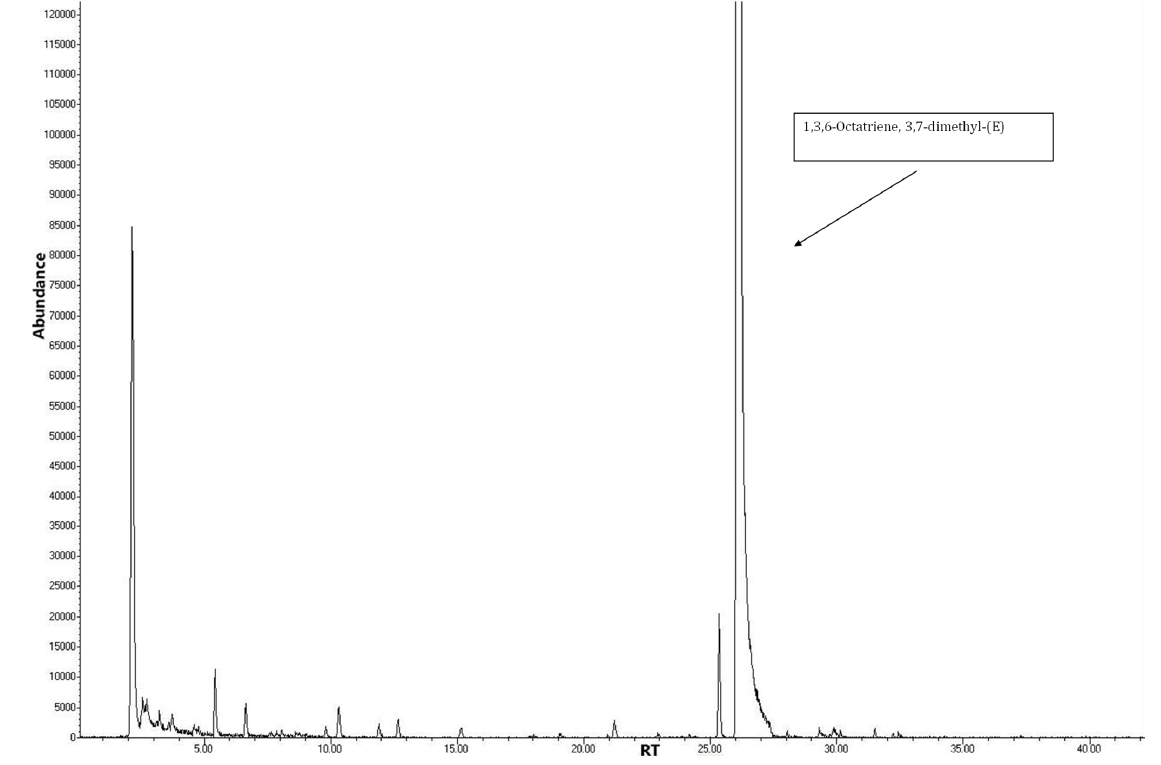
Figure 2. Representative chromatogram of healthy brood (RT: Retention Time).